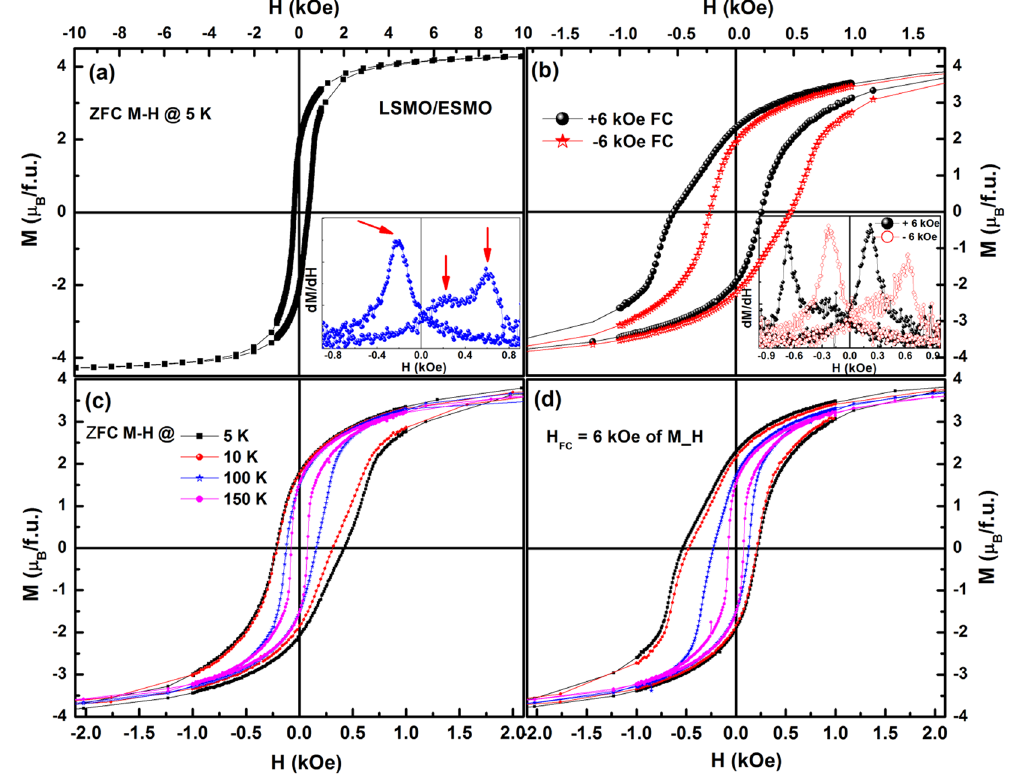
Figure 4. M(H) loops measured at 5 K in ZFC ( a ) and FC ( b ) modes for the LSMO/ESMO bilayers at 5 K, and their inset shows the dM/dH vs. H plots. ( c , d ) Is the isothermal M(H) loops at different temperatures for the ZFC and FC modes, respectively. For the clarity, only the data between − 10 kOe to 10 kOe are shown in the figures, while the actual measurements took place in between − 40 kOe to 40